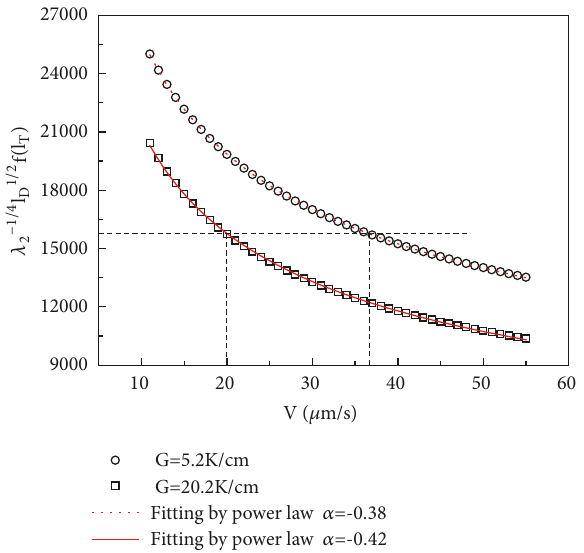
Figure 6: The variation of the value of right-hand side in (5) with pulling velocity for different thermal